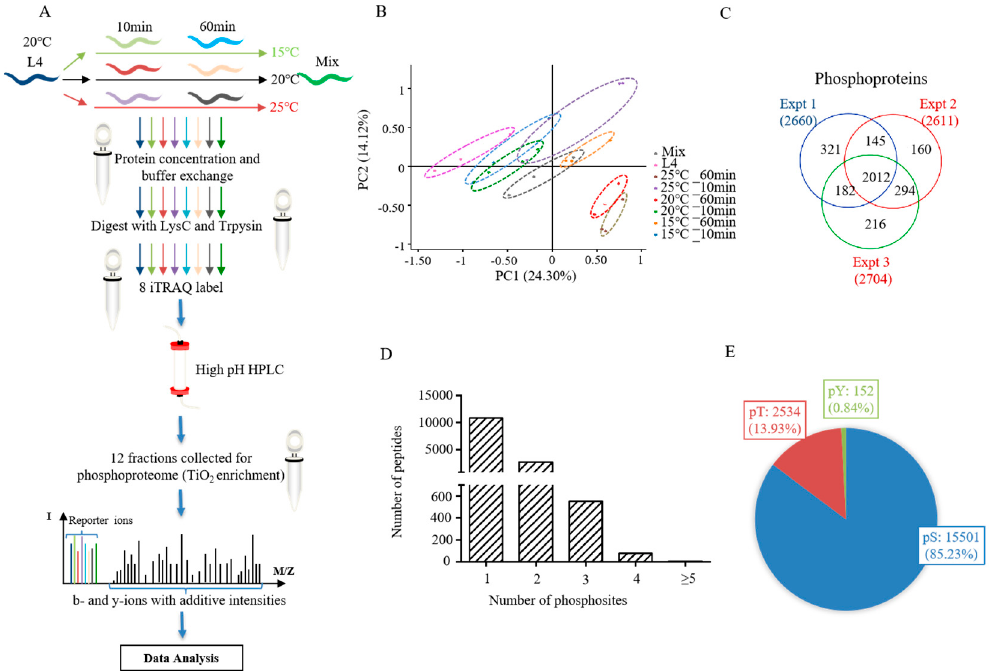
Figure 1. The quantitative phosphoproteome of Caenorhabditis elegans exposed to a mild temperature over a short-term period. (A) Scheme of the phosphoproteomic strategy. (B) Principal component analysis (PCA) of all quantified phosphoproteins. (C) The overlap of phosphoproteins in different triplicates of experiments. (D) The number distribution of phosphopeptide with different phosphosites. (E) The percentage of phosphorylated serine (pSer), threonine (pThr), and tyrosine (pTyr).